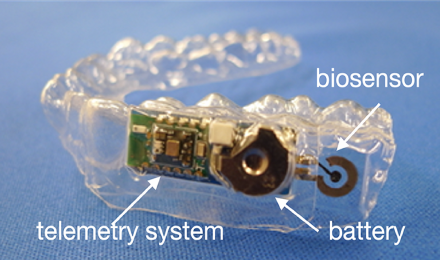
Figure 2. View of saliva-based design (Reprinted with permission from Ref. [29] © 2021 American Chemical Society).